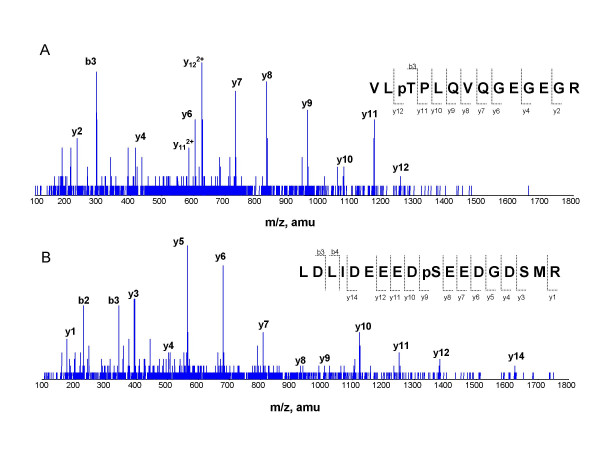
MS/MS spectra of the phosphopeptides VLpTPLQVQGEGEGR and LDLIDEEEDpSEEDGDSMR. Low-energy sequence ions (b and y-type ions) produced by collision-induced dissociation allowed for identification of several E1 phosphorylation sites after searching the tandem MS data against the NCBI nr sequence database with the MASCOT algorithm. A. Spectrum for VLpTPLQVQGEGEGR. B. Spectrum for LDLIDEEEDpSEEDGDSMR. The b and y-type ions are indicated on the peptide sequence and on the corresponding spectrum peak. A differential modification of 80 Da for serine and threonine was included in the MASCOT search parameters.